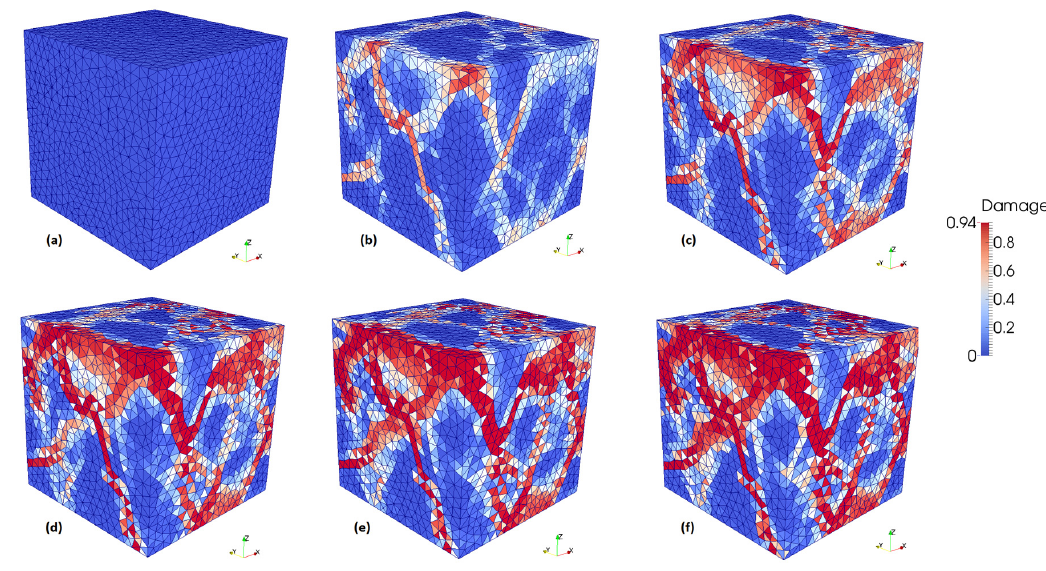
Figure 8. Compression damage evolution (from a to f ) for load applied in z-direction.